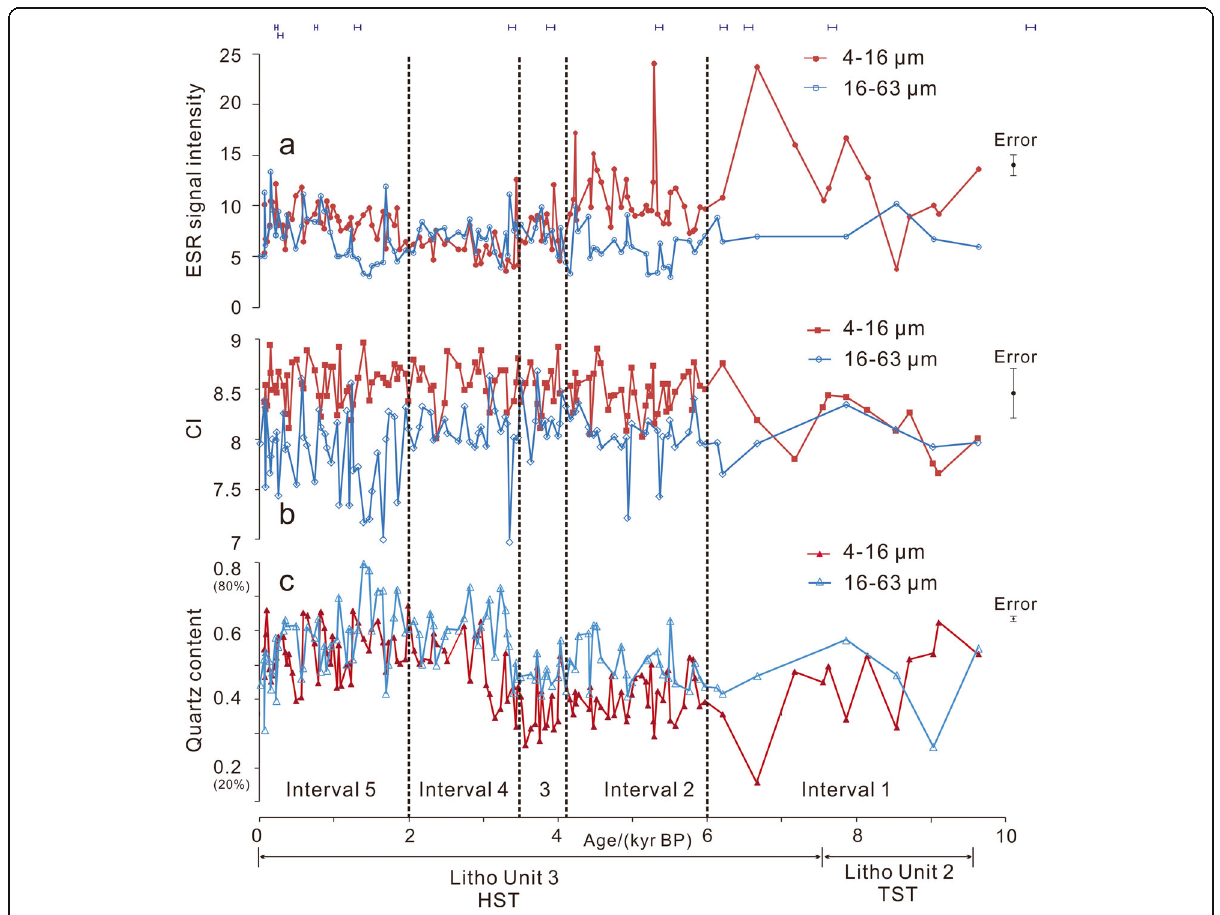
Fig. 3 Temporal changes in the ( a ) ESR signal intensity, ( b ) CI, and ( c ) quartz content in the fine silt fraction (4 – 16 μ m; red) and coarse silt fraction (16 – 63 μ m; blue) of the MD06-3040 core sediments. The calibrated 14 C dates of the MD06-3040 core are presented with 2 σ errors at the top of the figure. Lithostratigraphic units with HST and TST are presented at the bottom of the figure. The vertical dotted lines divide the temporal sequence into five intervals based on the temporal variation patterns of the ESR signal intensity, CI, and QC for the fine and coarse silt fractions, respectively